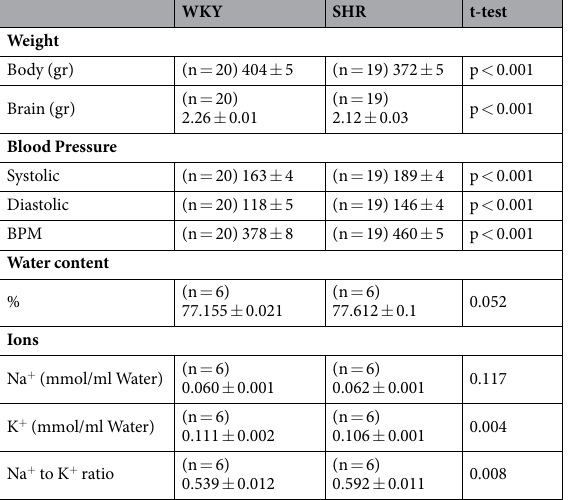
Table 1. Animal characteristics and brain composition. SHR body weight and brain weight were lower as compared to WKY. Systolic and diastolic blood pressure, and heart rate were elevated in SHR. Water content in SHR brain tended to be higher as compared to WKY. Whole brain sodium concentration was not different, but the potassium concentration was significantly lower in SHR brain as compared to WKY. Data are mean ±